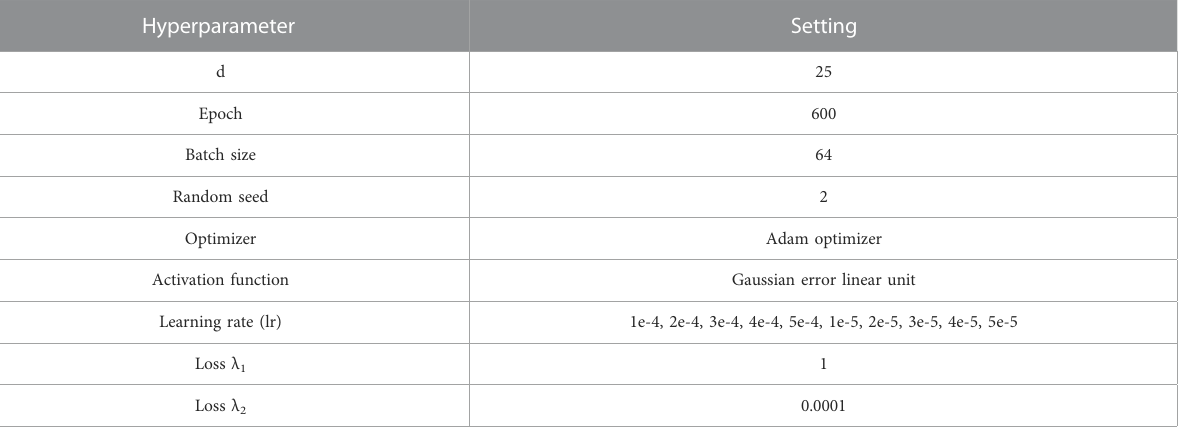
TABLE 2 Hyperparameter settings of SADLN